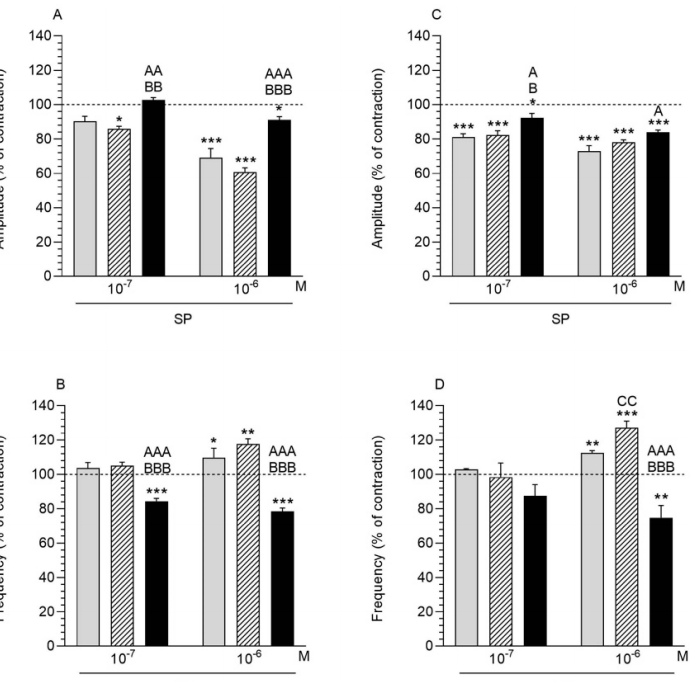
Figure 3. The effect of substance P (SP) on the contractile amplitude ( A , C ) and frequency ( B , D ) in the myometrium ( A , B ) and endometrium/myometrium ( C , D ) strips of gilts from the CON (grey bars), SAL (hatched bars) and E. coli (black bars) groups. Results were obtained from five pigs in each group. The effects of individual SP doses are depicted as percentages (mean ± SEM) of the baseline (pretreatment period) contractile amplitude and frequency, taken as 100% (horizontal lines). * p < 0.05, ** p < 0.01, *** p < 0.001 compared to the basal value in each group; A p < 0.05, AA p < 0.01, AAA p < 0.001 compared between the CON and E. coli groups for the same treatment; B p < 0.05, BB p < 0.01, BBB p < 0.001 compared between the SAL and E. coli groups for the same treatment; CC p < 0.01 compared between the CON and SAL groups for the same